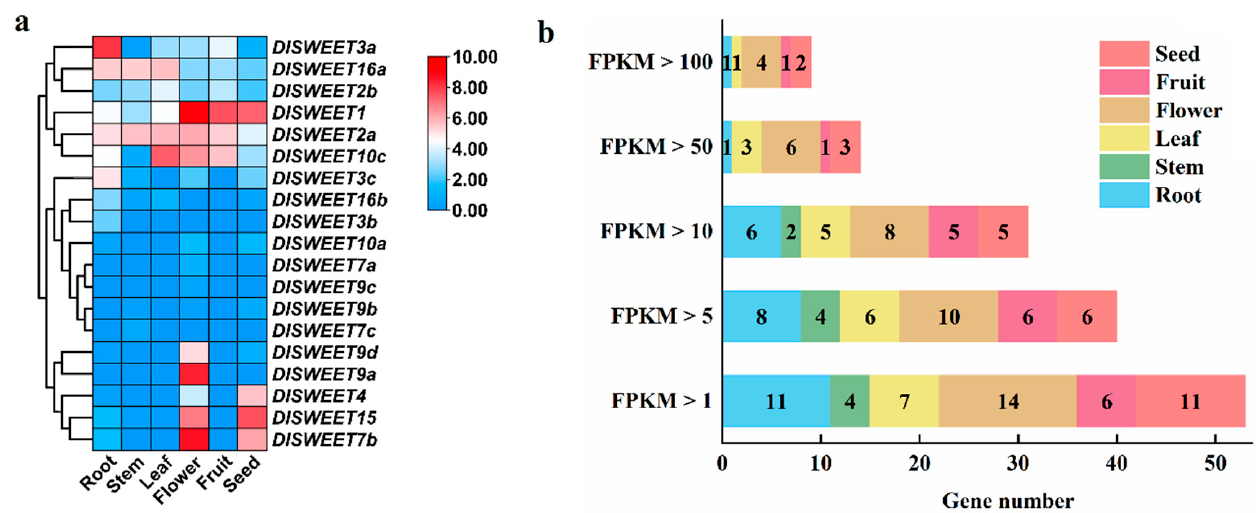
Figure 5. Tissue-specific expression profiles of DlSWEET genes. ( a ) Heatmap of expression levels for DlSWEET genes in six tissues (root, stem, leaf, flower, fruit and seed). The color scale represents log2 (FPKM+1) normalized transformed counts where blue indicates low expression and red indicates high expression. ( b ) The sum of the DlSWEET genes with different transcriptional abundance.